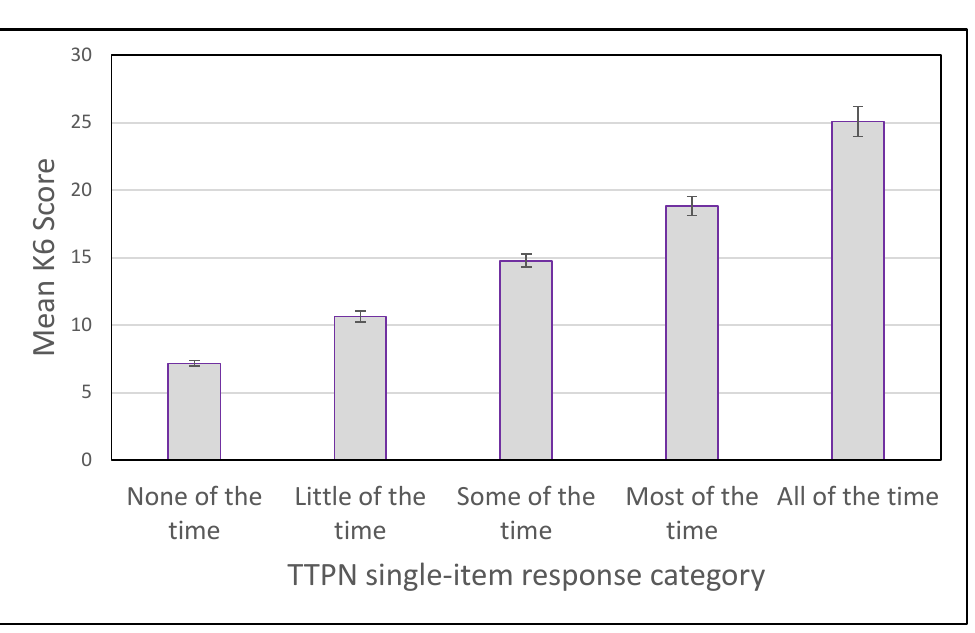
Figure 2. Mean K-6 score for each TTPN item category, with 95% confidence interval. Using the standard cut-point on the K6 for comparison, the ROC curve presented in Figure 3 plots the sensitivity against (1-specificity) for each value of the TTPN distress